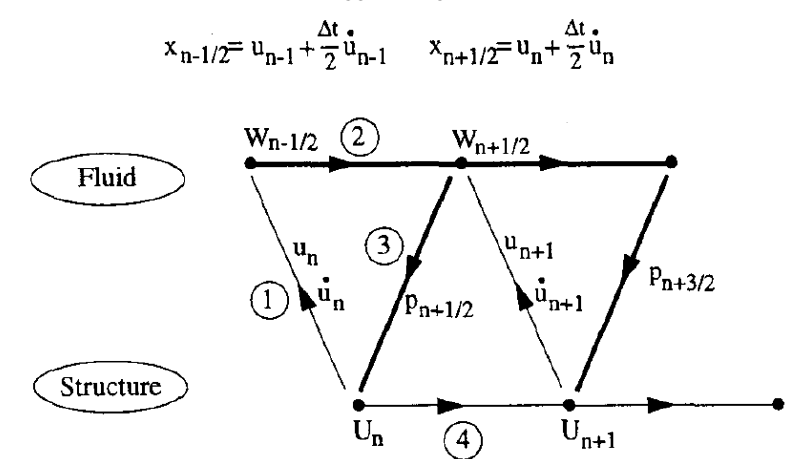
Figure 10. Conventional serial staggered algorithm with fluid subiterations.